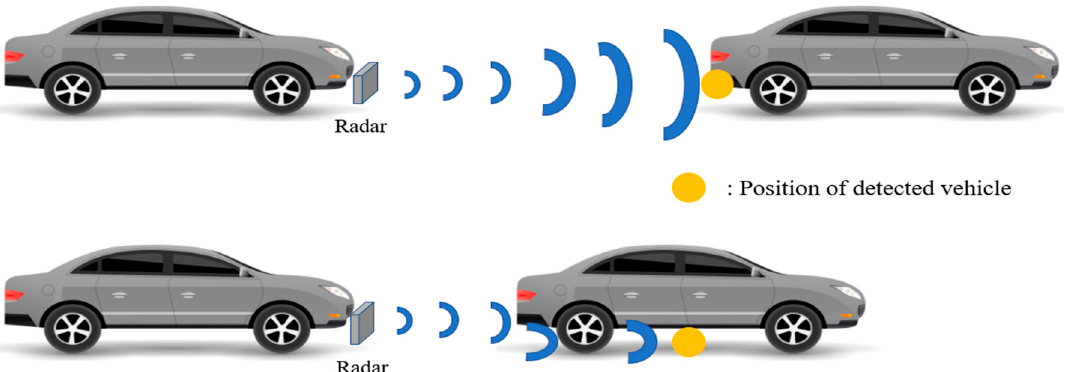
Figure 4. Problem in measurement values with the radar sensor.